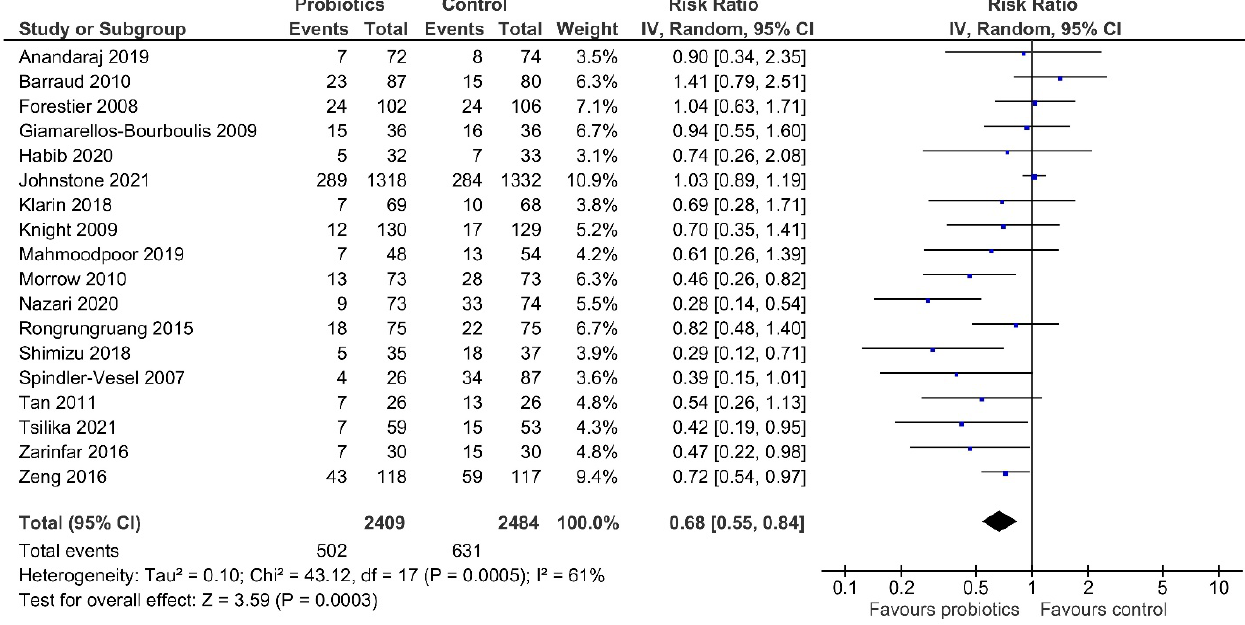
Figure 3. Comparison of incidence of VAP between patients receiving probiotics/synbiotics or control. VAP, ventilator-associated pneumonia; IV, inverse variance. Table 2. Grading of recommendations assessment, development, and evaluation (GRADE) summary of findings.